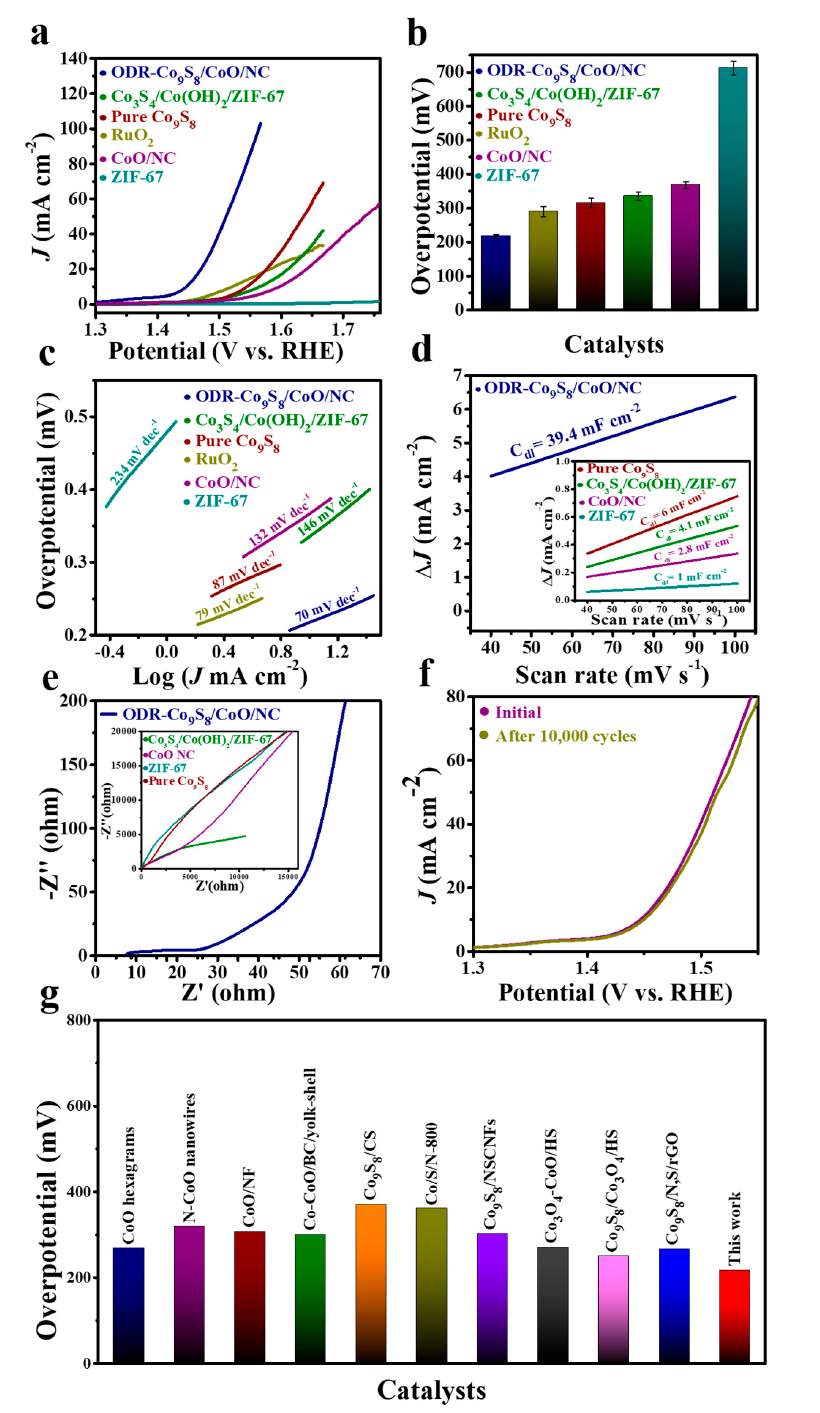
Figure 4. ( a ) OER performance ( b ) Overpotential comparison (The error bar represents the range of results from three independent measurements) and ( c ) Tafel slope of ODR-Co 9 S 8 /CoO/NC, RuO 2 , Co 3 S 4 /Co(OH) 2 /ZIF-67, ZIF-67, Co 9 S 8 , and CoO/NC in 0.1 M KOH. ( d ) Capacitive current measurements ( Δ J 0 = J a − J c ) and ( e ) Nyquist plots for ODR-Co 9 S 8 /CoO/NC, Co 3 S 4 /Co(OH) 2 /ZIF-67, ZIF-67, Co 9 S 8 , and CoO/NC. ( f ) The polarization curves after the first and 10,000th CV cycles. ( g ) Overpotential comparison of the as-prepared catalyst with previously reported Co-based compounds at J OER = 10 mA cm − 2 . The ODR-Co 9 S 8 /CoO/NC can also work as an efficient electrocatalyst in the HER. Fig- ure 5a compares linear sweep voltammetry (LSV) curves of the ODR-Co 9 S 8 /CoO/NC, ZIF- 67, Co 3 S 4 /Co(OH) 2 /ZIF-67, CoO/NC, pure Co 9 S 8 , and commercial Pt/C. Unsurprisingly,